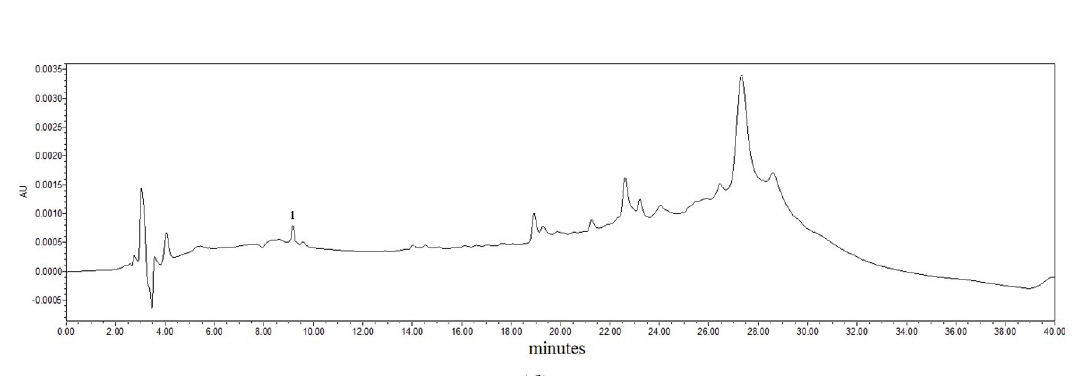
Figure 2. HPLC chromatogram of 12 HAs. ( a ) HAs standards detected with UV detection in 263 nm. ( b ) HAs standards detected with fluorescence detection. ( c ) HAs in a hock skin after 8th cycle detected with UV detection in 263 nm. ( d ) HAs in a hock skin after 8th cycle detected with fluorescence detection. Peaks: 1, IQ; 2, MeIQ; 3, MeIQx; 4, 7,8-DiMeIQx; 5, 4,8-DiMeIQx; 6, Norharman; 7, Harman; 8, Trp-P-2; 9, PhIP; 10, Trp-P-1; 11, AαC; 12, MeAα.